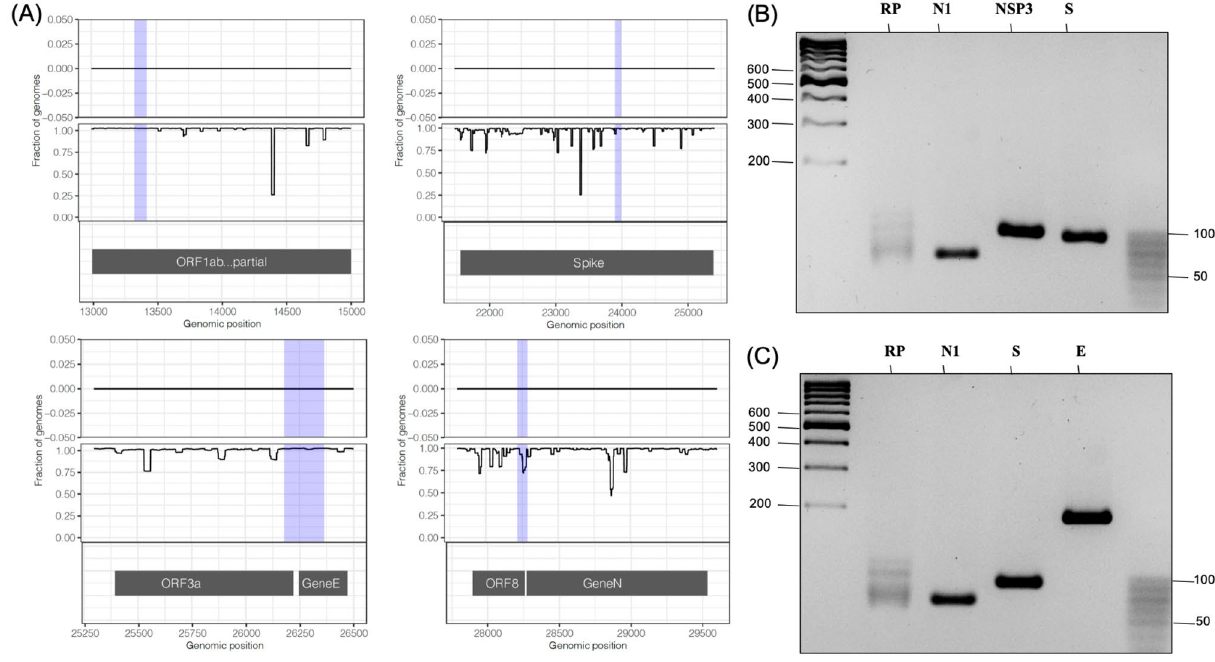
Figure 2. ( A ) Environmental and population landscapes are shown for each selected region. A panel is included for all primers used in this study. The shadowed blue regions represent the amplicons generated by the PCR primers: upper left, primer NSP-3; upper right, primer S; lower left, primer E and lower right, primer N1. Upper track : number of occurrences of each reference kmer in the environmental sequences; upper and middle track: X-axis shows the genomic position for the start of each reference kmer, Y-axis, shows the percentage of either environmental sequences (upper track) or SARS-CoV-2 population genomes (middle track) that contain a given reference kmer; lower track, genomic annotation. ( B ) 4% agarose gels showing the end-point RT-PCR amplification product when using as sample a positive control (SARS-CoV-2 RNA) with the primers RP and N1 (CDC recommended primers) as well as the NSP3 and S primers generated by the kmer method. ( C ) 4% agarose gels showing the end-point RT-PCR amplification product when using as sample a positive control with the RP, N1, S and E